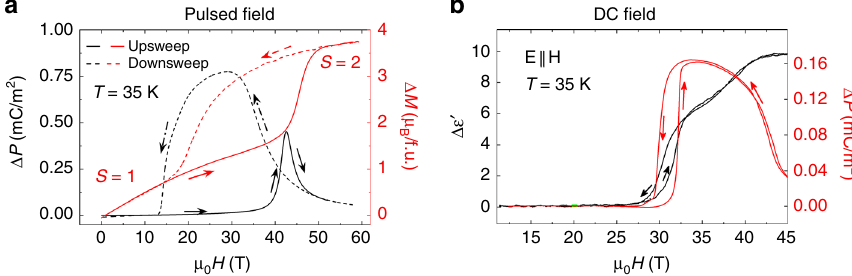
Fig. 3 The change in electric polarization, magnetization, and dielectric constant at the SST. a Pulsed- fi eld electric polarization Δ P ( H ) (left axis, black) and change in magnetization Δ M ( H ) (right axis, red) at T = 35 K for increasing and decreasing pulsed magnetic fi elds. Here E || H || [ 110 ] where E and H are the direction of the electric polarization and magnetic fi eld. The magnetization is measured on a randomly oriented collection of single crystals. b Quasi-DC fi eld dielectric constant Δ ϵ ′ ð H Þ (left axis, black) and electric polarization Δ P ( H ) (right axis, red) for increasing and decreasing quasi-DC fi elds. The loss tangent for dielectric measurements is less than 10 − 5 and E || H || [ 110 ]. The standard errors due to random noise are smaller than the line widths except for DC dielectric constant data, where the data are averaged, and the standard error is